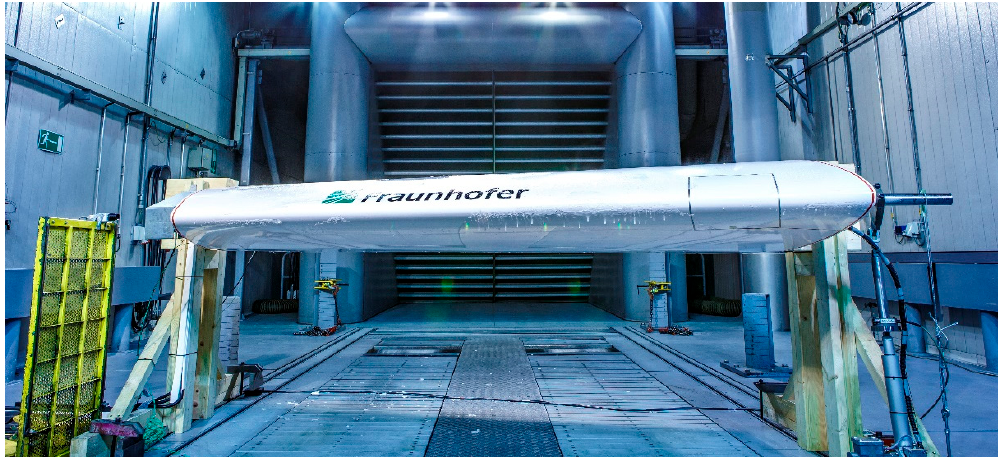
Figure 1. Fraunhofer morphing leading edge demonstrator in the climate wind tunnel.